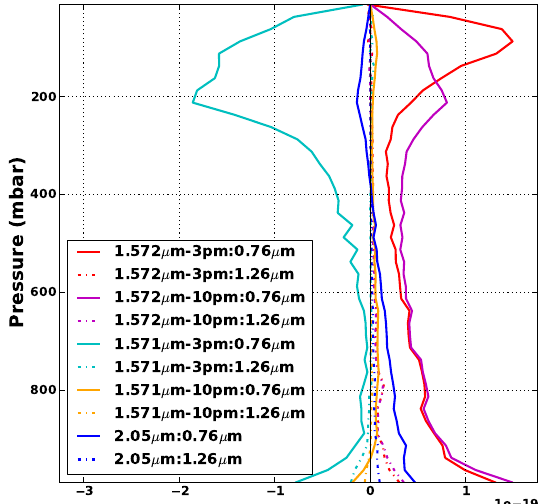
Figure 5. The in-layer covariance of the differences between dif- ferential optical depths derived from observed and modeled atmo- spheric soundings, as a function of pressure (in 25mb layers). The covariances between the CO 2 instruments and the 0.76µm are uni- formly larger than those with the 1.26µm instrument. Also, the 3pm offset instruments have large covariances near the tropopause, which is consistent with Fig. 4.